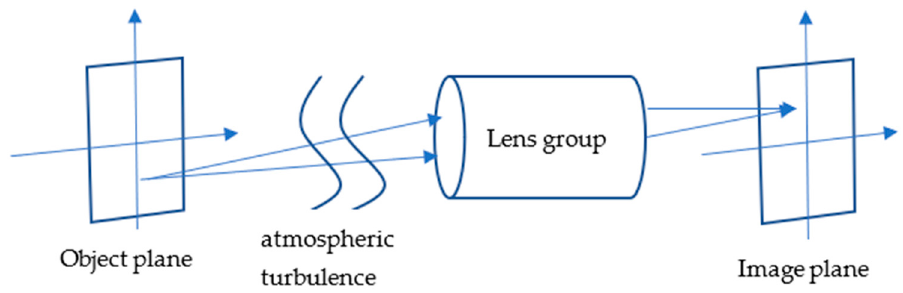
Figure 3. The model of optical imaging system.